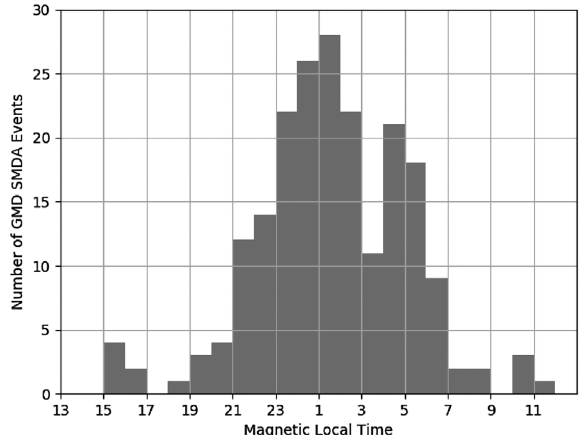
Fig. 5. Local time distribution of harmonic distortion events observed by Hydro-Québec SMDA monitoring system, 2014 – 2017. Local time was taken from an average of longitudinal extremes of substations which may trigger the